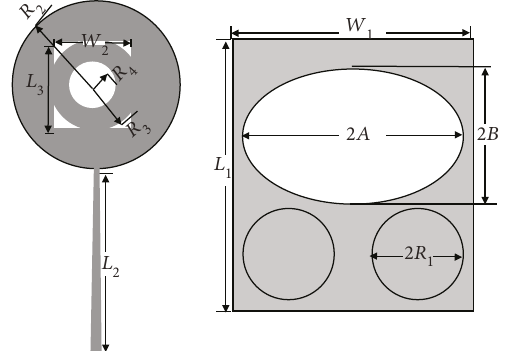
Figure 11: A wide slot microstrip antenna with three slots, one elliptical and two circular [49].